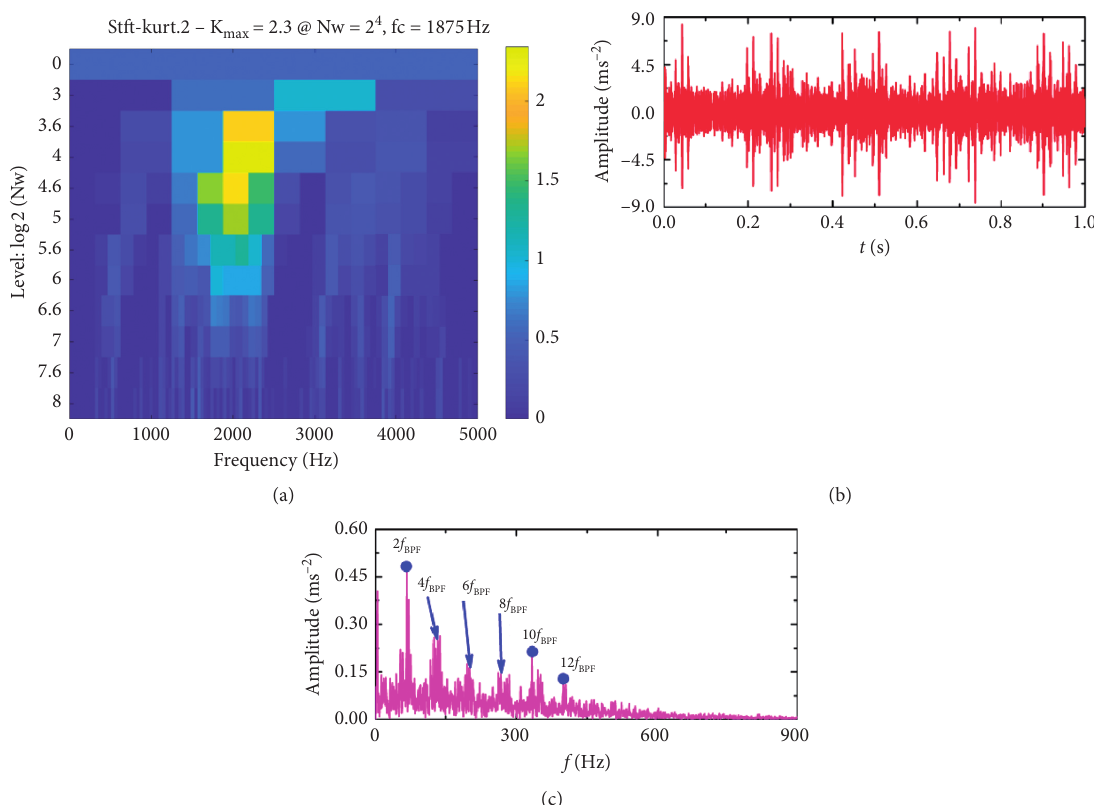
Figure 23: Results obtained by fast kurtogram: (a) kurtogram, (b) extracted signal, and (c) Hilbert envelope spectrum of signal in (b). Table 3: Comparison among the three methods.